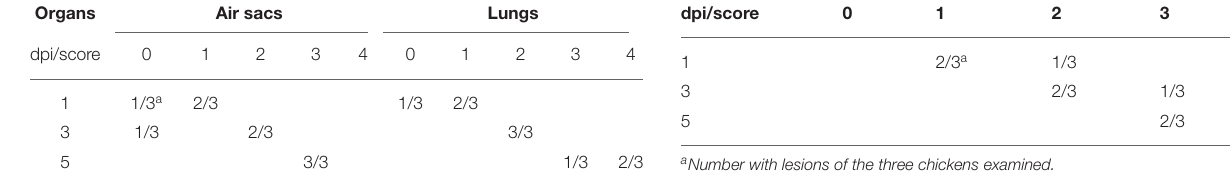
TABLE 2 | Gross lesions scoring of the right infected air sacs and lungs. Organs